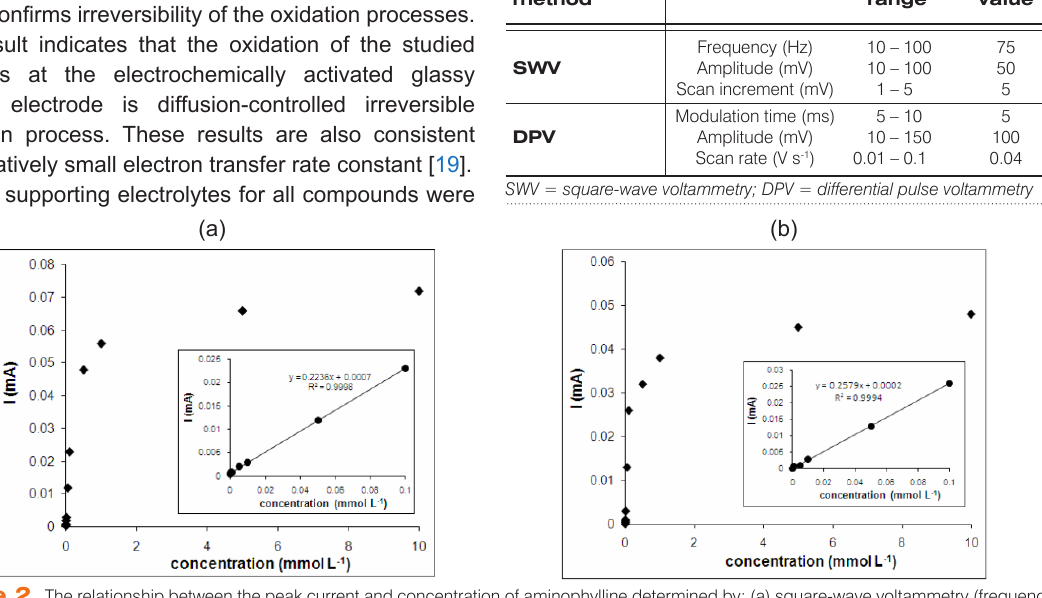
Table 1. SWV and DPV parameters and their optimum values Voltammetric method